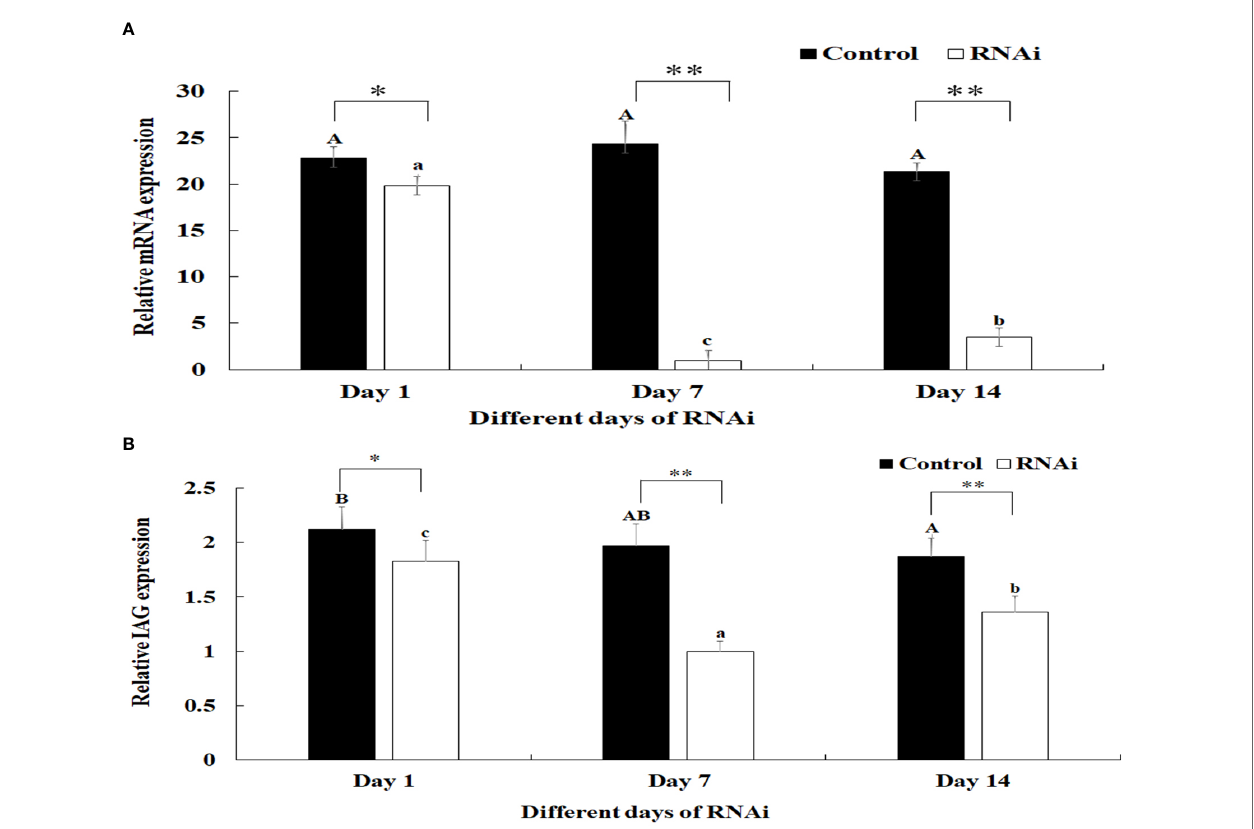
FIGURE 8 | (A) Expression characterization of Mn-PDHE1 at different days after Mn-PDHE1 dsRNA injection. (B) Expression characterization of Mn-IAG at different days after Mn- PDHE1 dsRNA injection. The amount of Mn-PDHE1 and Mn-IAG mRNA was normalized to the EIF transcript level. Data are shown as mean ± SD (standard deviation) of tissues from three separate individuals. Capital letters indicated expression difference between different days after vehicle injection in control group. Lowercase indicated expression difference between different days after Mn-PDHE1 dsRNA injection in RNAi group. *(p < 0.05) and **(p < 0.01) indicates signi fi cant expression difference between the RNAi group and control group at the sample